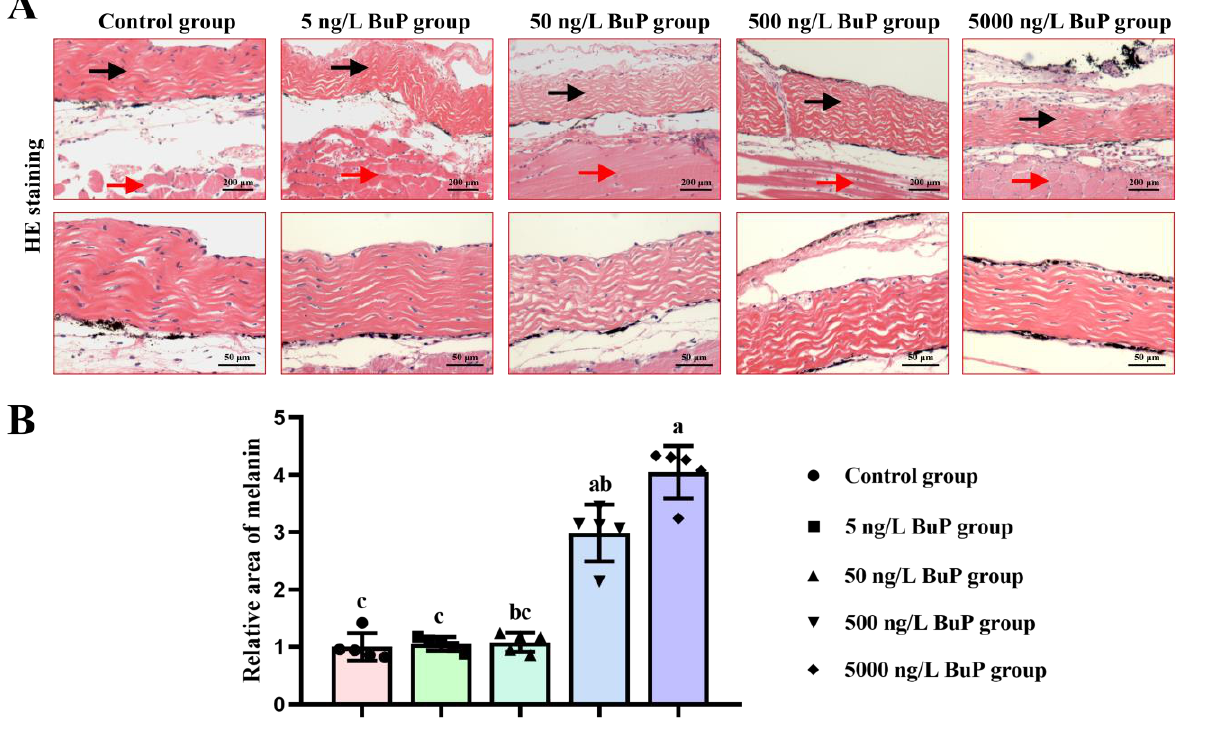
Figure 2. Effects of BuP on the morphological structures in skin tissues. HE staining ( A ); relative area of melanin ( B ). Black arrows indicate the dermis; red arrows show the muscle layer. Means of groups not sharing a common letter are significantly different at p < 0.05.